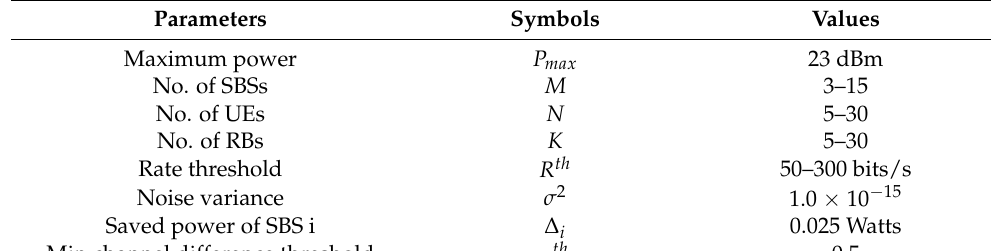
Table 2. Evaluation Parameters.